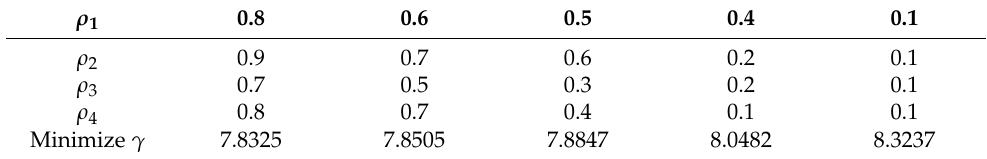
Table 2. The H ∞ performance index γ and solver time for different quantization density ρ i in case